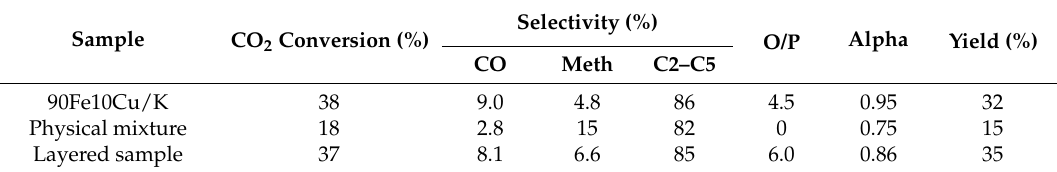
Table 3. Comparison of activities between the Fe90Cu10/K sample, a physical mixture of Fe100/K and Cu100/K, and a layered sample.